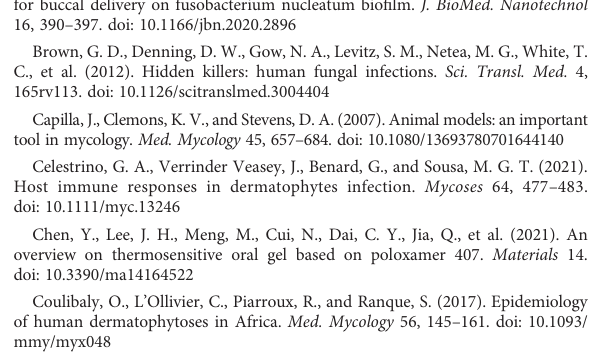
SUPPLEMENTARY FIGURE S1 Hyphal invasion of the epidermis: Extensive hyphal invasion of the stratum corneum (thick arrow) on day 13 of T. mentagrophytes , which causes acanthosis (two headed arrow) and in fi ltration of in fl ammatory cells (star) at the site of infection (see inset for a zoomed in view). SUPPLEMENTARY FIGURE S2 MIC of AXD in vitro : (A) development of mild infection in immunocompetent mice. (B) Picture of MIC of AXD against T. mentagrophytes (TM) and T. rubrum (TR). (C) A single locus of residual hyphae post drug treatment shows an almost complete clearance of infection. SUPPLEMENTARY FIGURE S3 Skin histology images post drug treatment: Zoomed out (Magni fi cation 2x) images of surface area of skin to visualize clearance of infection in TER and AXD treated mice. Scale bars = 500